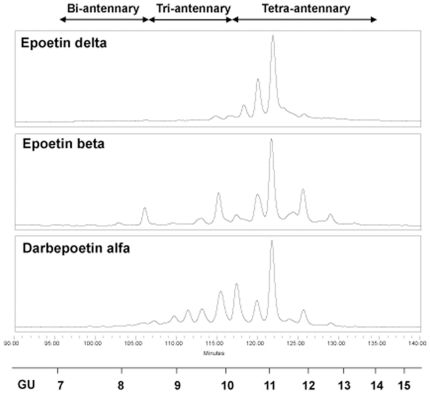
Glycan profiling.Normal phase HILIC profiles of N-linked glycans released from epoetins and labelled with 2-aminobemzamide. The sections of the profiles where bi-, tri- and tetra-antennary glycans elute are indicated at the top of the figure. The elution positions are shown against a scale of glucose oligomers used to calibrate the column.